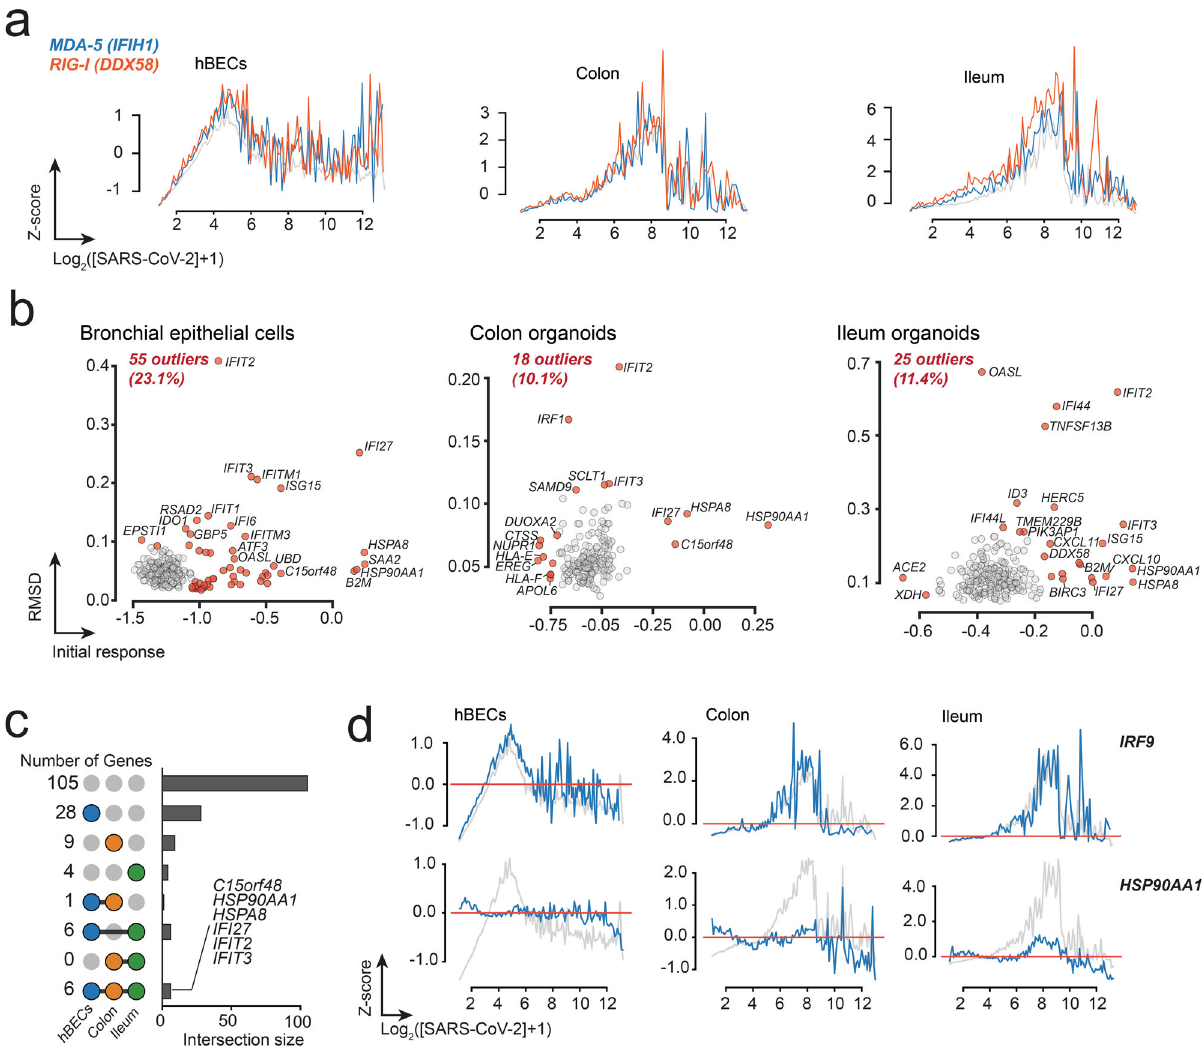
Fig. 3 Global transcriptional response of ISGs in human bronchial epithelial cells, colon-, and ileum-organoids. a The transcriptional response of the cytoplasmic viral receptors MDA-4 and RIG-I correlated with the mean transcriptional response. Enrichment of GO terms associated with both signaling pathways are indicated. b Distribution of RMSD and Δ 0 pro fi les of ISGs. Genes considered to be outliers are shown in red. c Upset plots illustrating the number of outlier ISGs shared among the three datasets. The fi rst row corresponds to ISGs exhibiting an average response in the three datasets. The six genes exhibiting a differential response to SARS-CoV-2 infections in the three cell types are indicated. d Representative examples of ISGs exhibiting average ( IRF9 ) and abnormal ( HSP90AA1 ) transcriptional responses to SARS-CoV-2